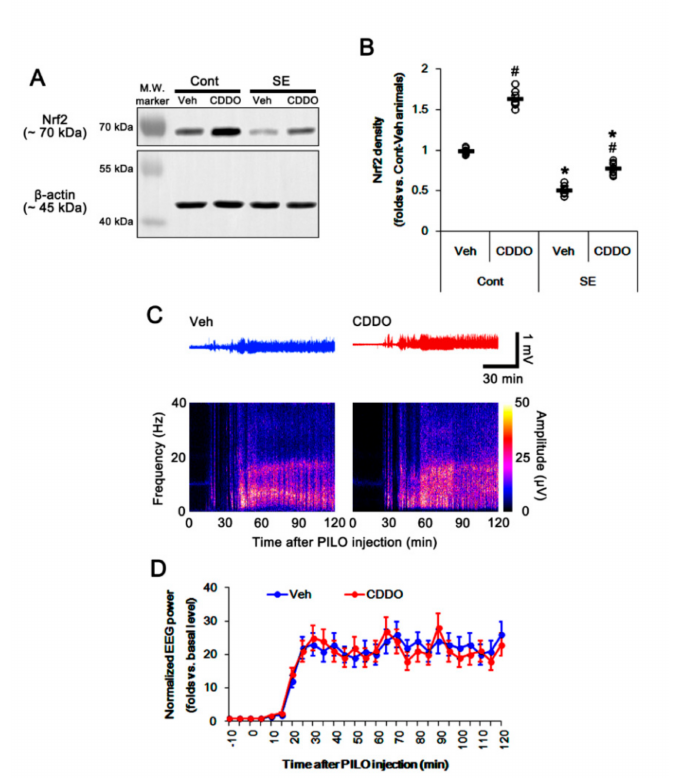
Figure 1. E ff ects of 2-Cyano-3,12-dioxo-oleana-1,9(11)-dien-28-oic acid methyl ester (CDDO-Me) on nuclear factor-erythroid 2-related factor 2 (Nrf2) expression and seizure activity in response to pilocarpine. ( A , B ) E ff ect of CDDO-Me on Nrf2 expression in response to pilocarpine. CDDO-Me increases Nrf2 expression under physiological conditions. Pilocarpine-induced status epilepticus (SE) decreases Nrf2 expression, which is attenuated by CDDO-Me. ( A ) Representative Western blots of Nrf2 expression. ( B ) Quantification of Nrf2 expression based on Western blot data. Open circles indicate each individual value. Horizontal and vertical bars indicate mean value and S.E.M., respectively (mean ± S.E.M.; *,# p < 0.05 vs. control animals and vehicle, respectively, one-way ANOVA followed by Newman–Keuls post hoc test; n = 7, respectively). ( C , D ) E ff ect of CDDO-Me on seizure activity in response to pilocarpine. CDDO-Me does not influence seizure activity induced by pilocarpine. ( C ) Representative electroencephalogram (EEG) traces and frequency-power spectral temporal maps in response to pilocarpine. ( D ) Quantification of total EEG power (seizure intensity) in response to pilocarpine. Open circles and vertical bars indicate mean value and S.E.M., respectively (mean ± S.E.M.; repeated one-way ANOVA; n = 7,